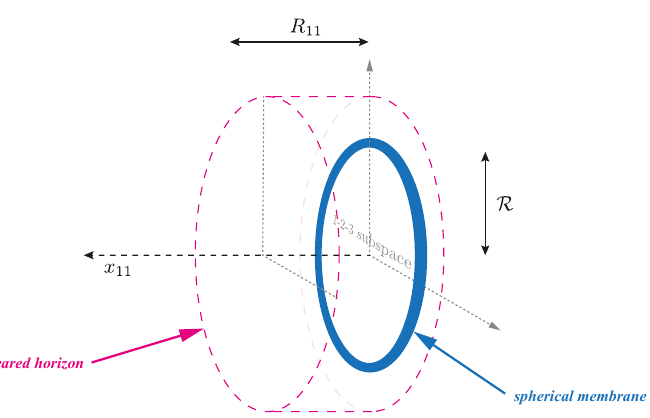
Figure 2 . A cartoon of the smeared light-cone black hole resulting from a heavy spherical mem- brane. A two dimensional cross section of the 1-2-3 subspace is